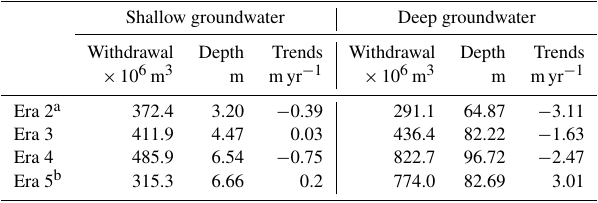
Table 2. Changes in shallow and deep groundwater withdrawal and table depth from Era 2 to Era 5.